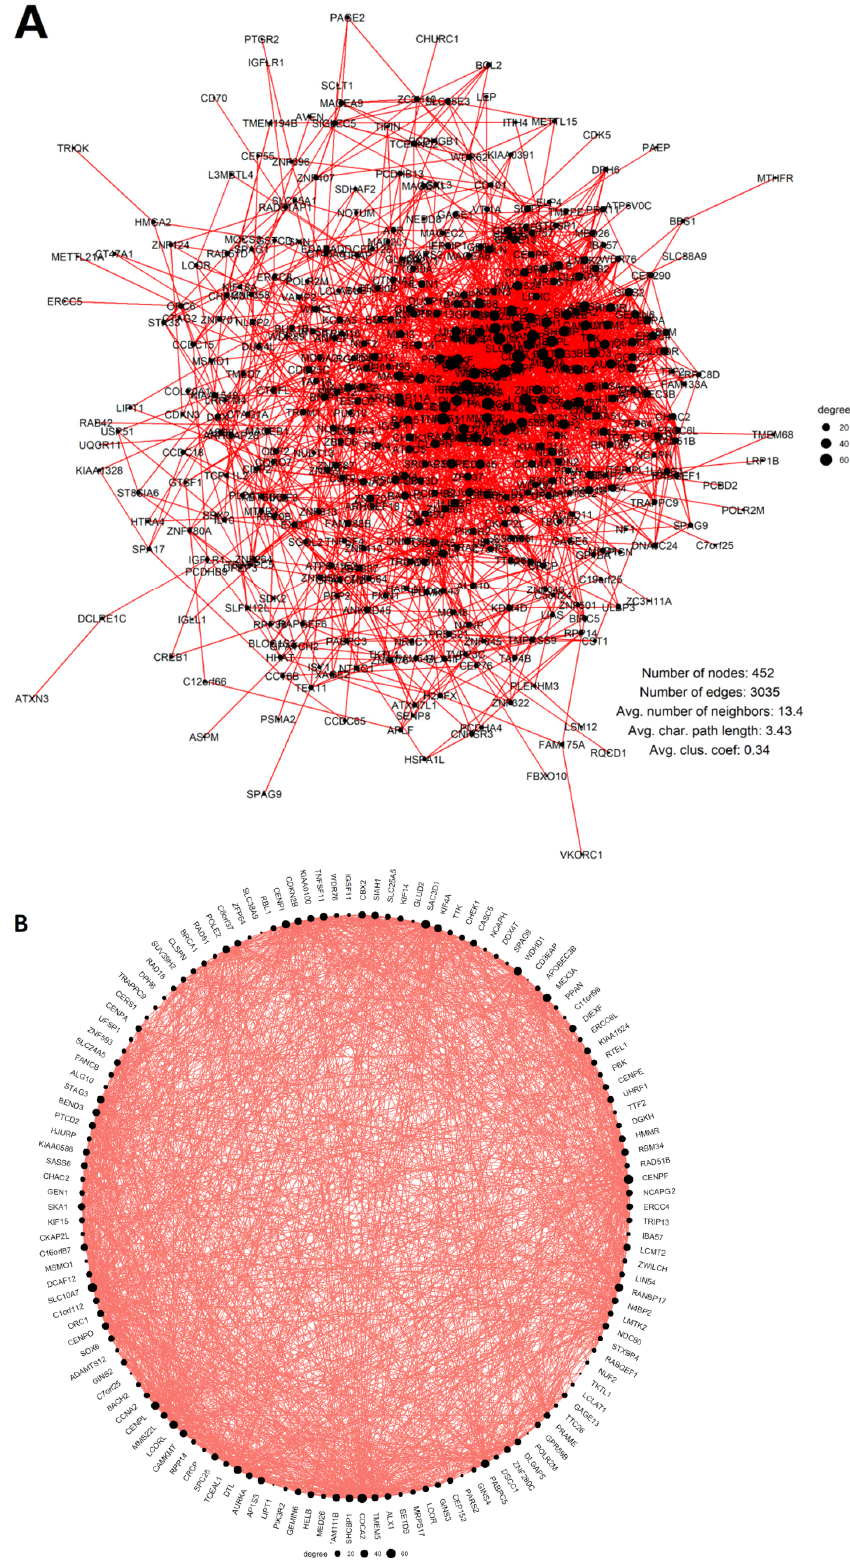
Figure 7. The coexpression networks of GG proteins in the MM500 database [101] melanoma proteomes (node size scaled to a degree): ( A ) The full network of GG proteins in 142 late-stage MM samples; ( B ) The most interconnected component (MCL Cluster 1) of the GG protein coexpression network, displayed in a circular layout.